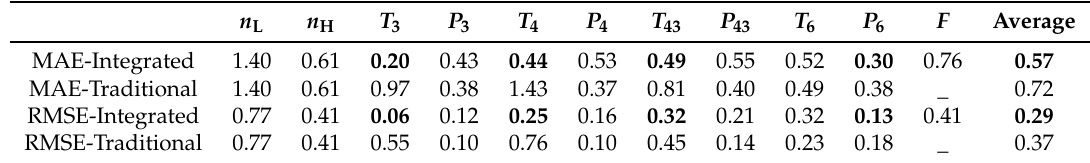
Table 3. MAE and RMSE considering the input noise